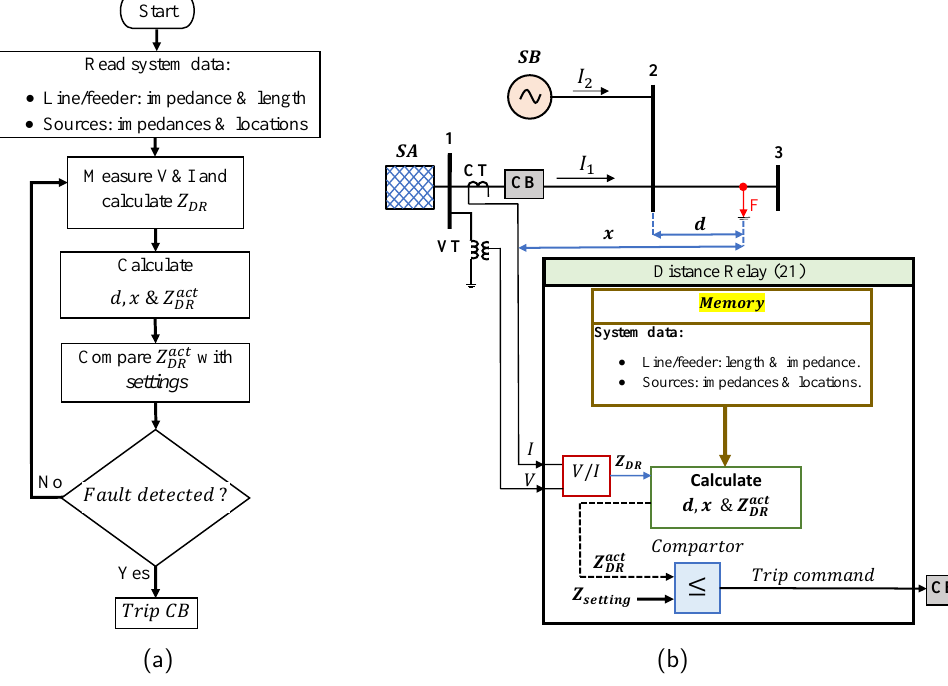
Figure 14. Method 3 for calculating the feeder impedance in presence of infeed effect: ( a ) flowchart of Method 3; ( b ) simplified schematic diagram of Method